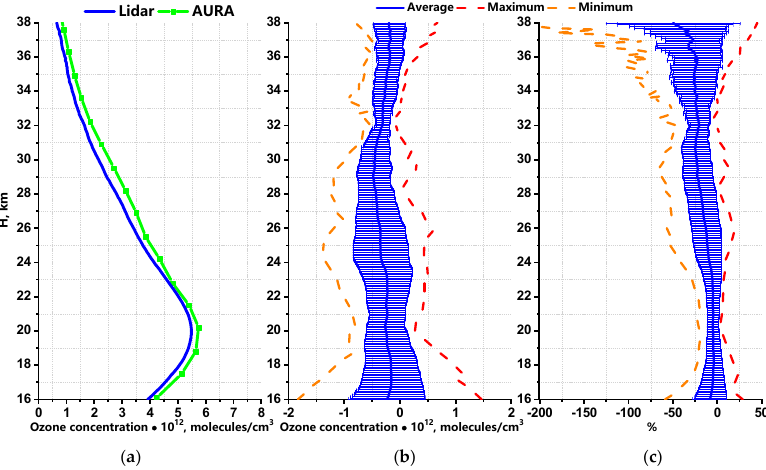
Figure 4. Average OVDs and their differences: ( a ) average profiles; ( b ) differences between the lidar and Aura data, in absolute units; ( c ) relative differences 100 × (lidar − Aura )/lidar.